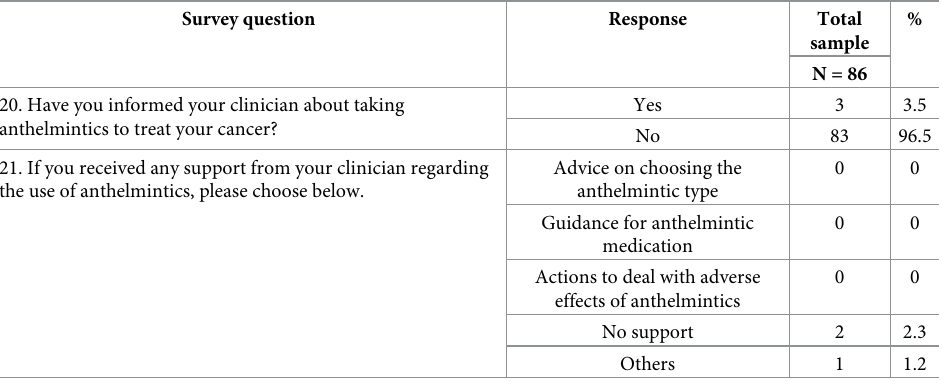
Table 5. Details about the communications between patients and